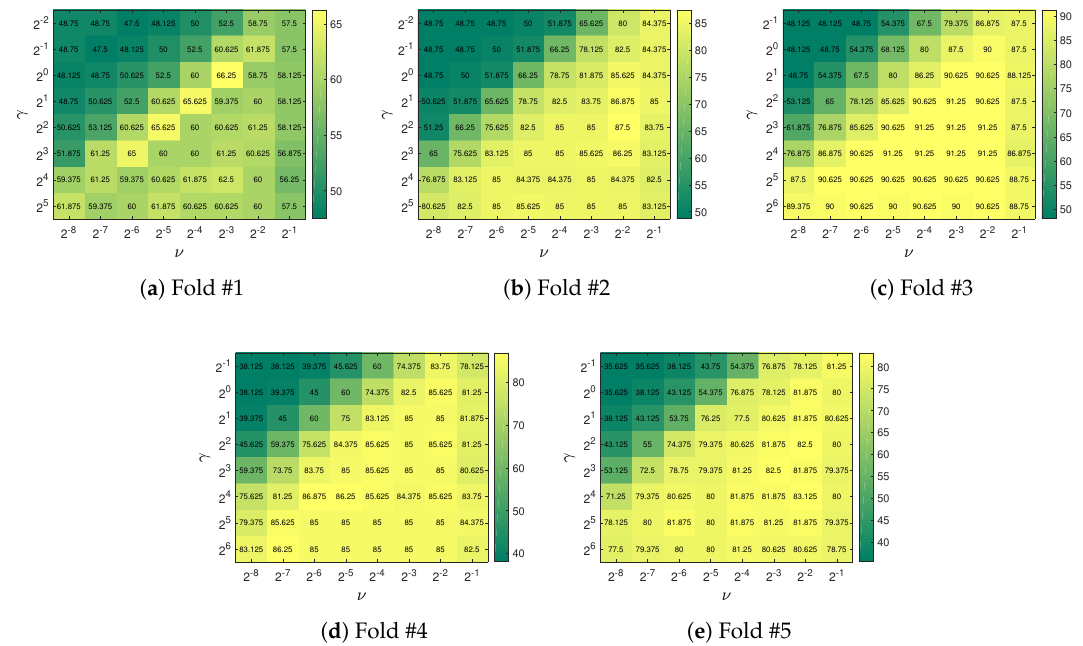
Figure 13. Grid search results (%) of nu-SVM over 5-fold cross-validation. Table 3 lists the hyperparameter optimization results for k -NN over the 5-fold cross-validation. As shown in the table, the optimal hyperparameters found at each cross-validation of each dataset were mutually different. In the table, the person identification accuracy of each k -NN over the 5-fold cross-validation is also listed. The results in the table show that k -NN achieved an average accuracy of 86.5%. Table 3. Hyperparameter optimization results for k -NN over 5-fold cross-validation. Fold #